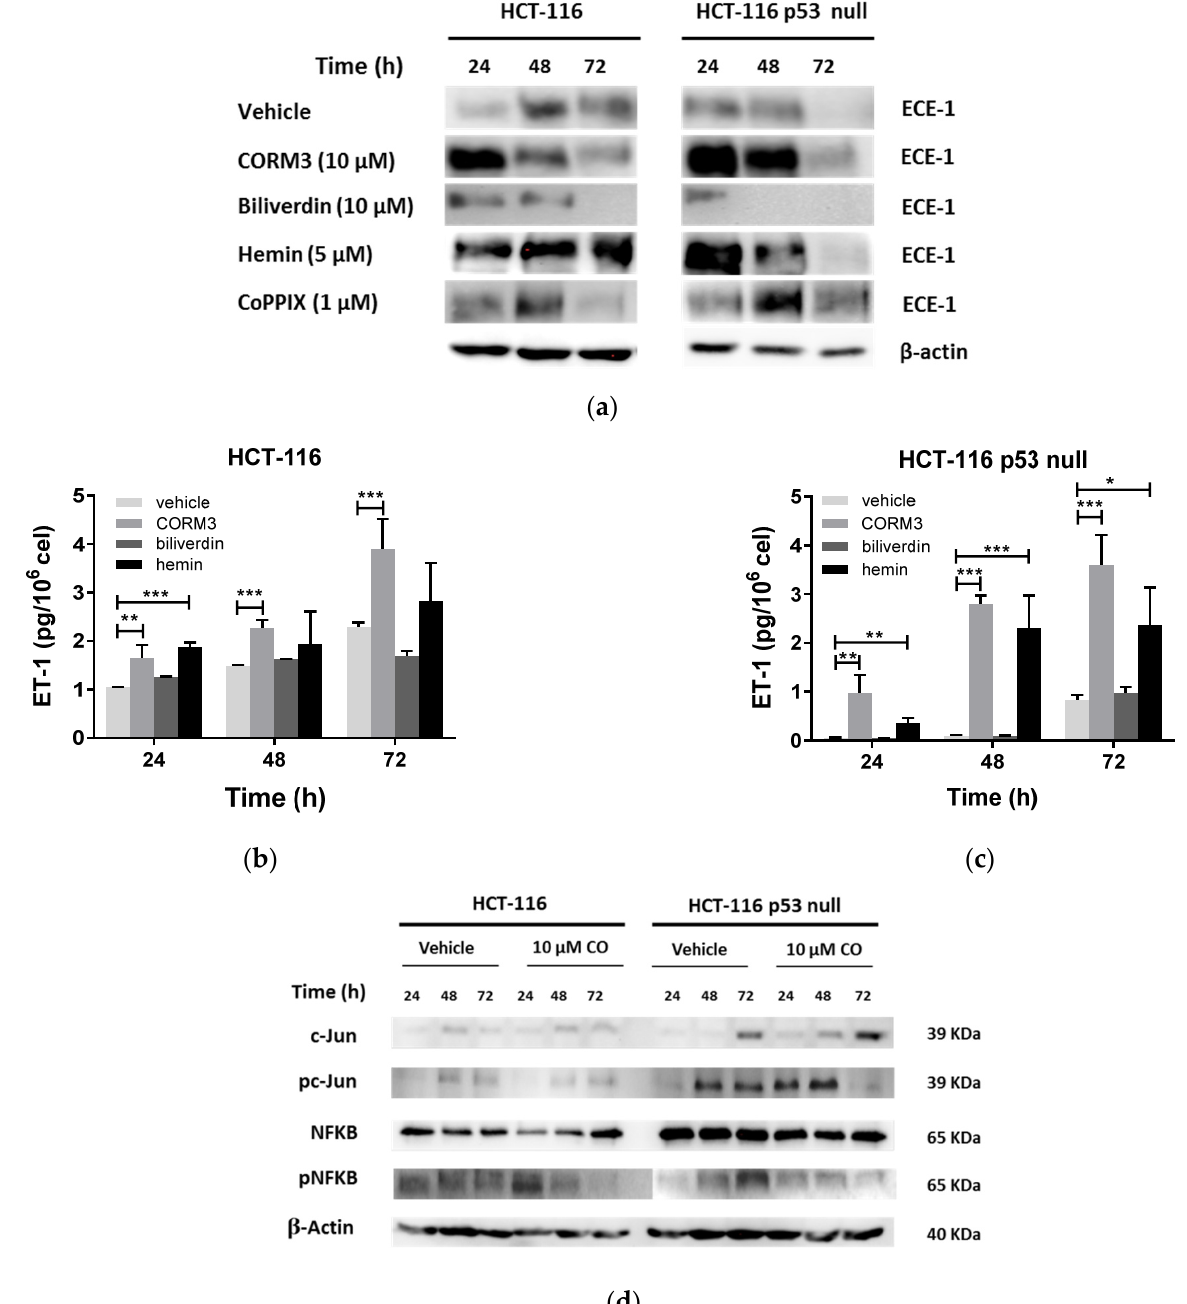
Figure 5. CO induces ECE-1 expression in CRC cells in vitro through the activation of NF-k β and c-Jun in HCT-116 and